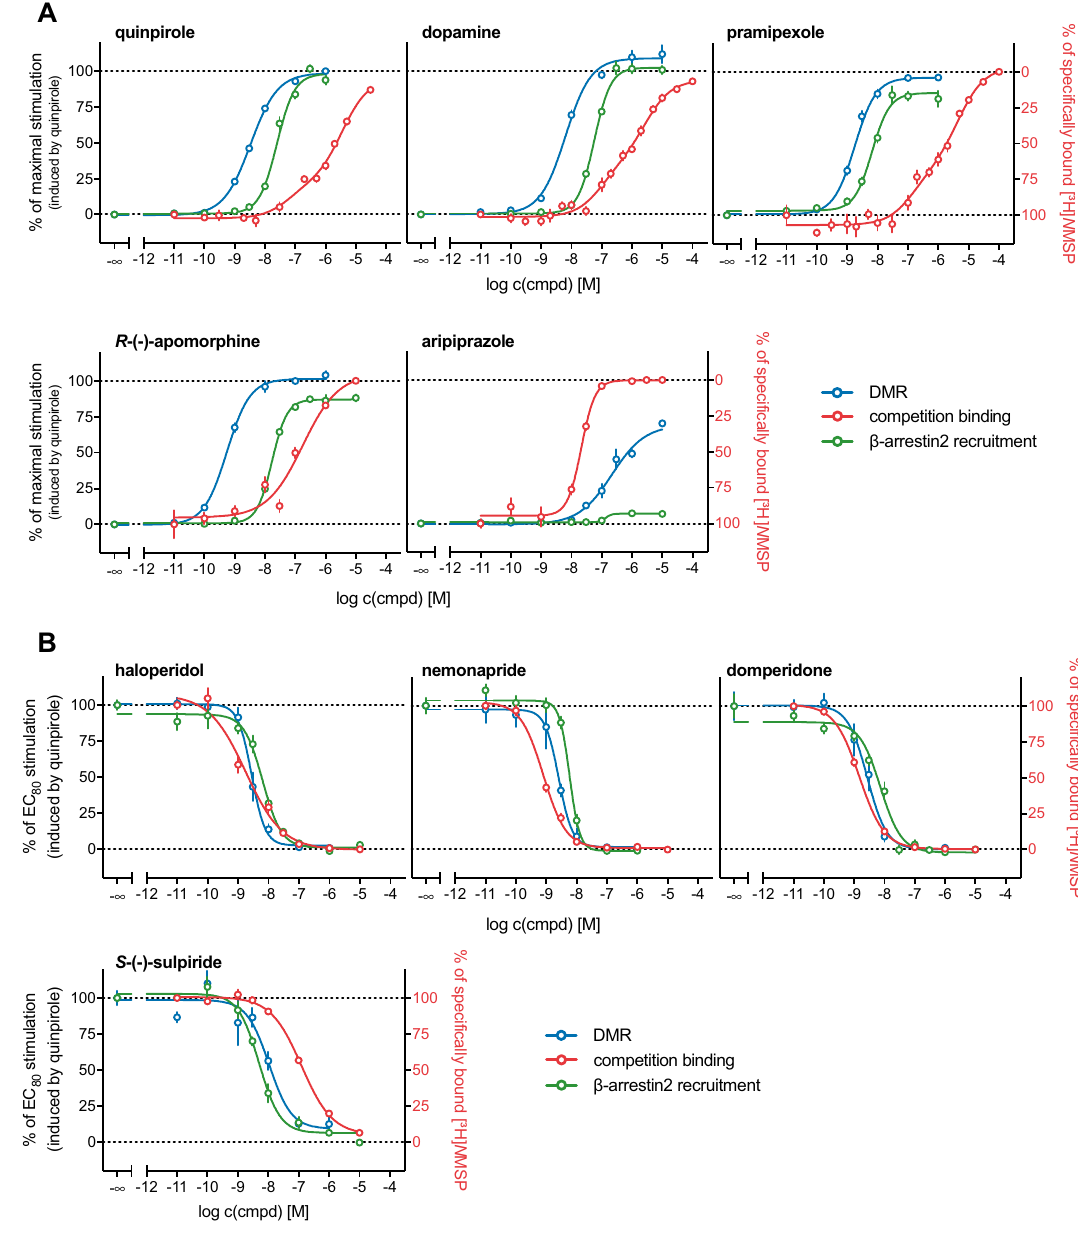
Figure 5. (A) Concentration–response and competition binding curves of selected dopamine D 2long R agonists from different assay types. ( B ) Inhibition and competition binding curves of selected dopamine D 2long R antagonists from different assay types. Data were normalised to the response induced by quinpirole at concentrations of 100 nM (β-arrestin2 recruitment) or 30 nM (DMR). The right Y-axis was inverted for illustration purposes. Competition binding experiments were performed on homogenates of HEK293T CRE Luc hD 2long R cells. β-Arrestin2 recruitment assays were performed using whole HEK293T ELucN-βarr2 hD 2long R-ELucC cells and the DMR measurements were carried out using whole CHO-K1 hD 2long R cells. Data represent means ± SEM from at least three independent experiments, each performed in